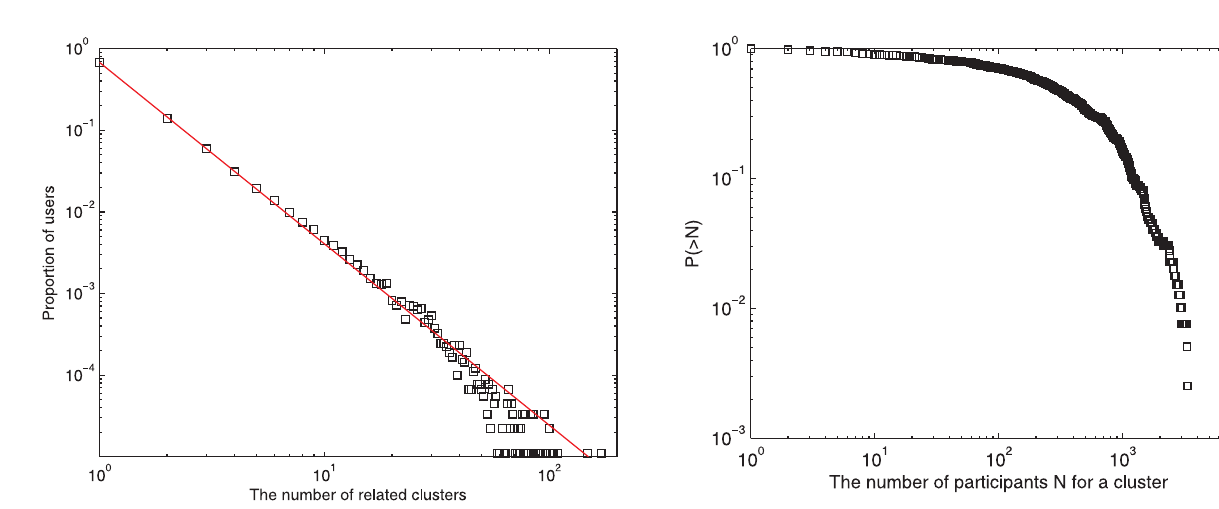
Figure 2. Cumulative distribution of the number of partici- pants for each topic cluster in Tianya BBS. About 90 percent of clusters attract more than 10 participants, indicating some of the least popular topics can still have some followers. Meanwhile, when N is large, the probability curve decreases significantly with the increase of N , and only a tiny fraction of topics attract several thousand users. The intermediate quantity 100 ƒ N ƒ 1000 occupies at least 80 percent of topic clusters, implying 100 ƒ N ƒ 1000 is the common pattern of